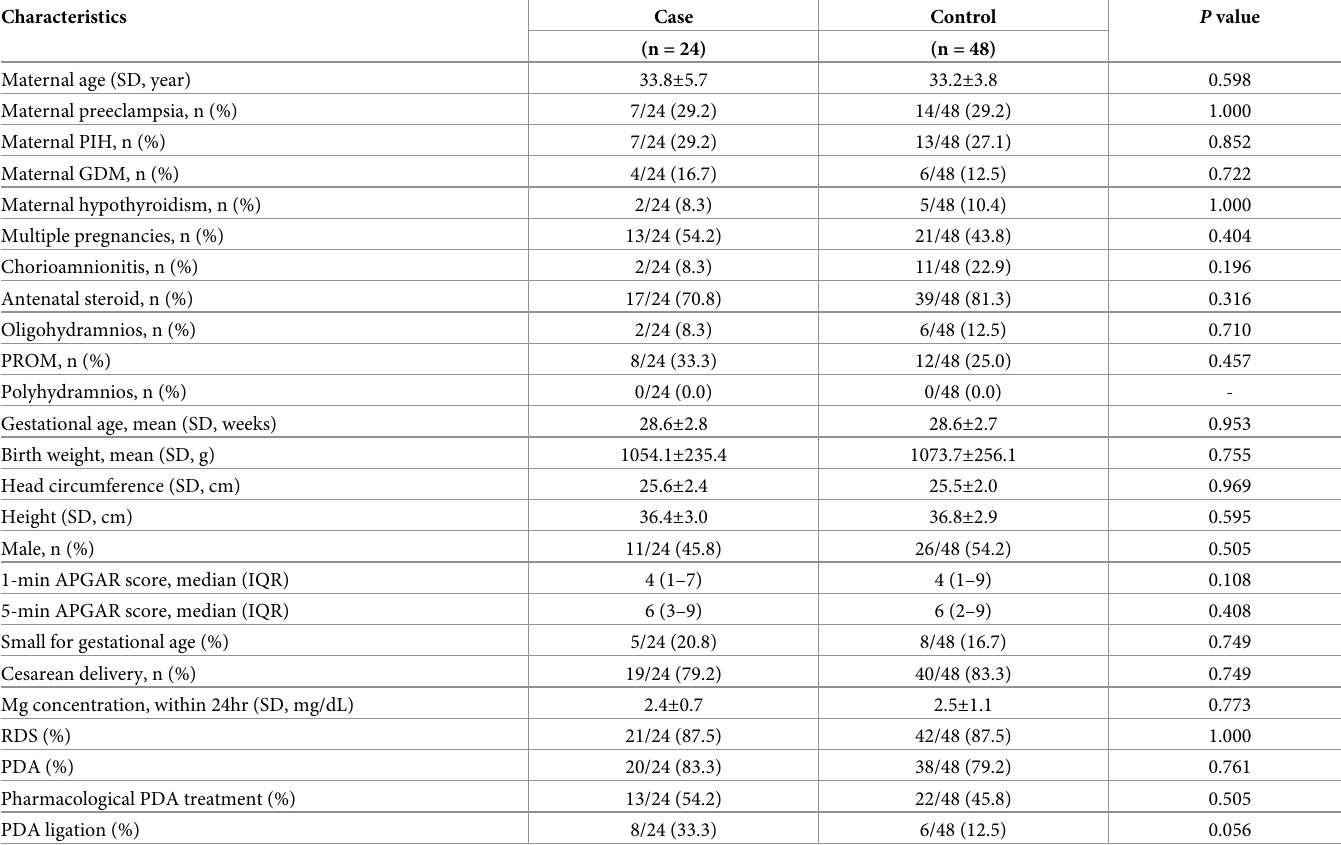
Table 1. Patients’ perinatal history and demographics and clinical